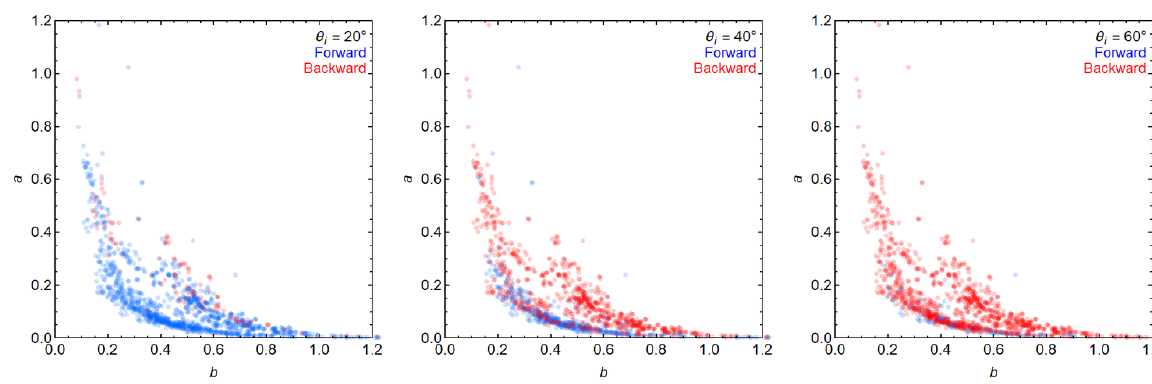
Figure 17. Surface roughness parameter a as a function of surface roughness parameter b (Eq. 1) of the dominantly backscattering and dominantly forward scattering profiles for incidence angles 20, 40 and 60 ◦